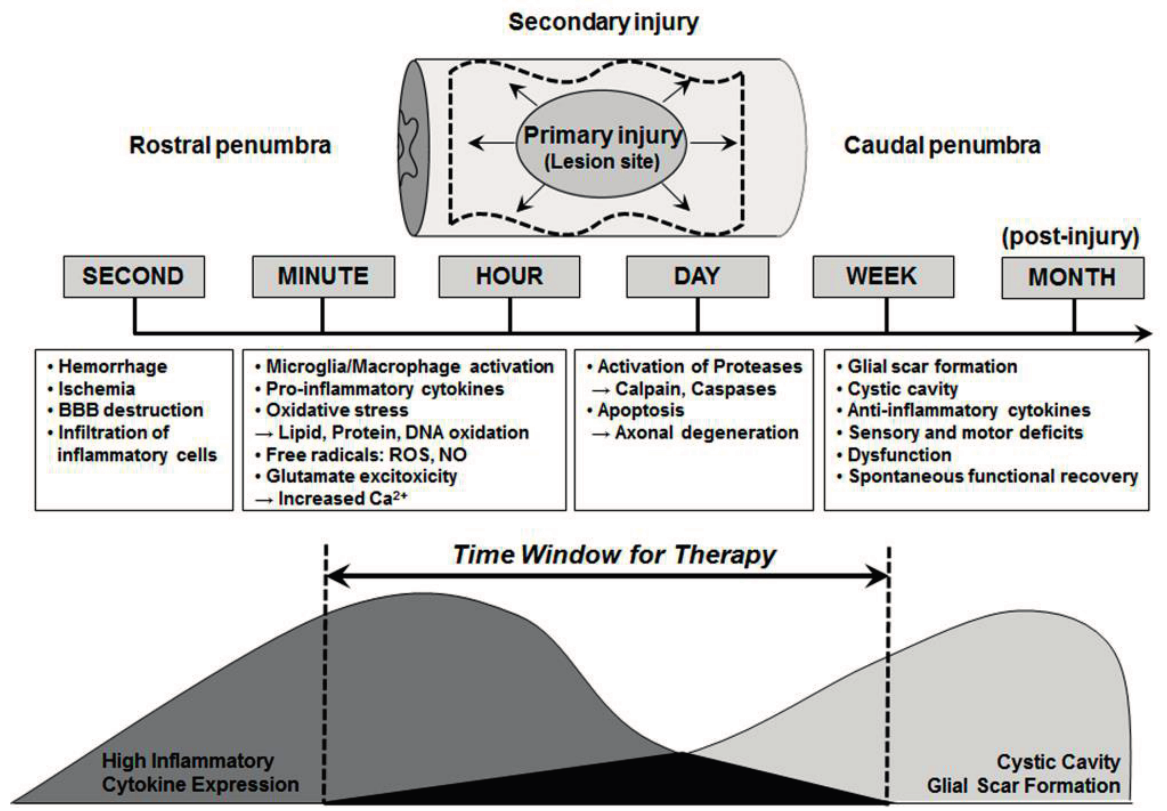
Figure 1. Time window for multi-active therapies. Time schedules of various events are progressed following neural injury including neurodegeneration, neurotrauma,